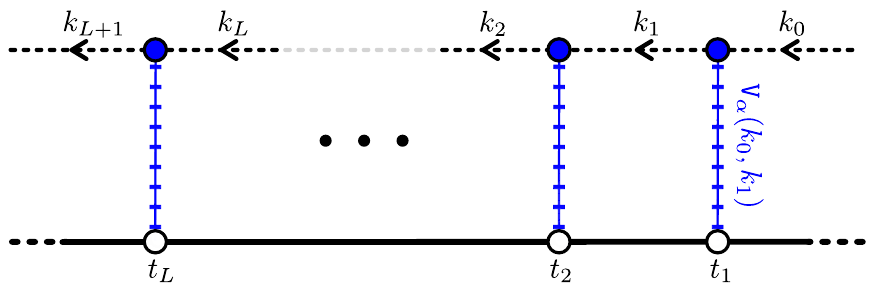
Figure 5 . In the lightcone gauge, the only diagram that contributes to the expectation value of the mesonic operator is given by the ladder-type diagrams shown in this figure. Here, the blue line and the filled blue blob represent the effective vertex function (2.39). This vertex is the sum of the gluon-scala-scalar derivative vertex connected by a gluon propagator to the line, and the bi-scalar insertion at the same point on the